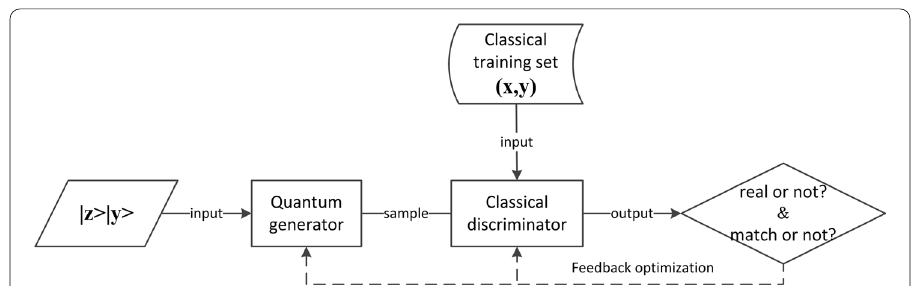
Fig. 4 Schematic diagram of quantum conditional generative adversarial